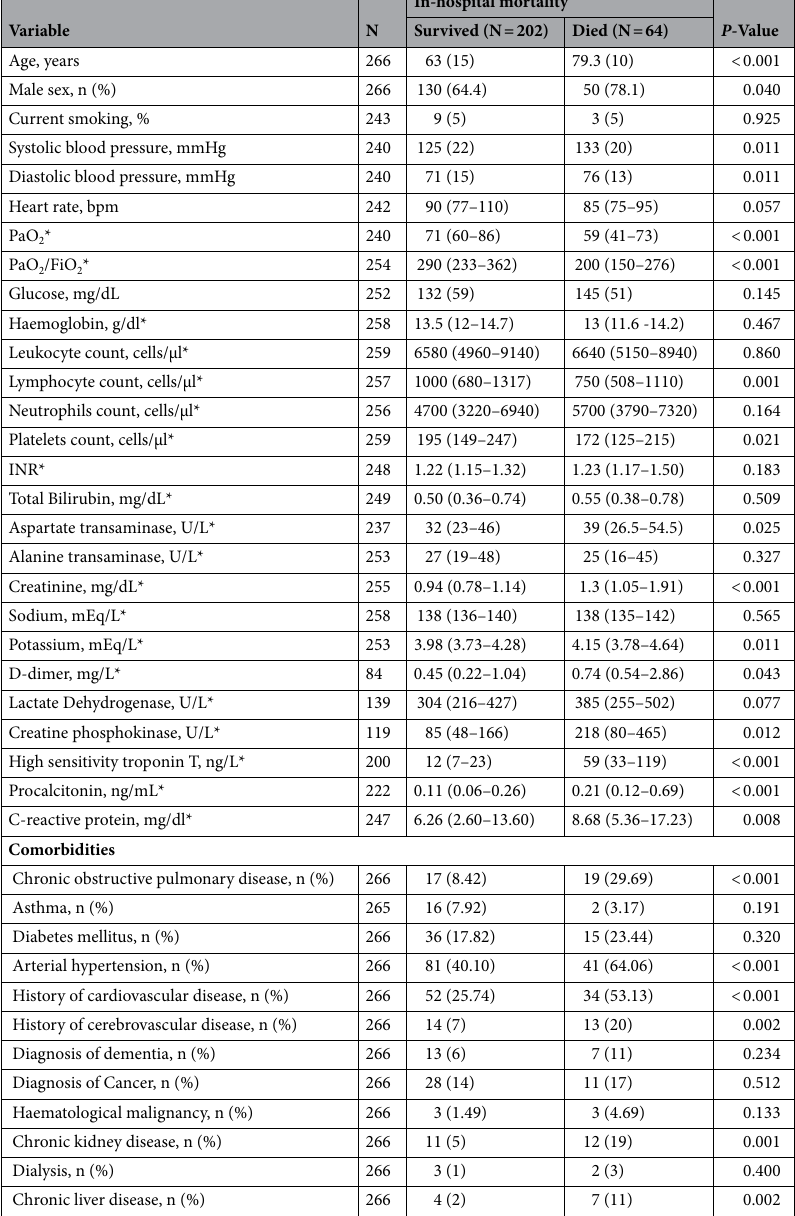
Table 1. Differences in clinical characteristics at admission according to survival status. P -values are derived from independent samples Student’s T Test or the Mann Whitney test for continuous variables and the chi squared test for categorical variables; *Median and interquartile